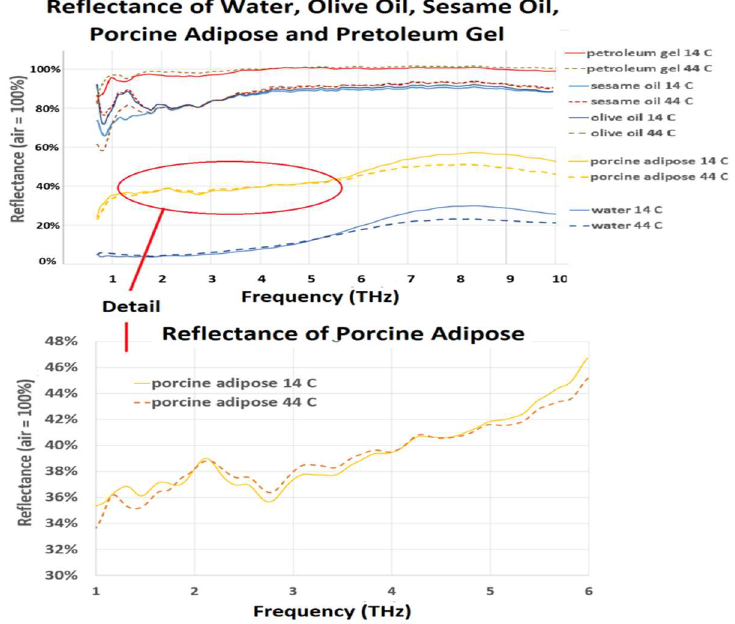
Figure 5. Reflectance data for porcine adipose tissue, olive oil, sesame oil, and petroleum gel ( top ), with detail in the 1.0 THz to 4.5 THz range shown on the ( bottom ) for porcine adipose tissue. The spectral data for the oil specimens show a high reflectance, in keeping with their low α . There is temperature variation in reflectance noted at frequencies < 2.0 for these samples. The reflectance data for petroleum gel are stable and featureless. Porcine adipose tissue shows features of both water content and fat content in its spectrum.